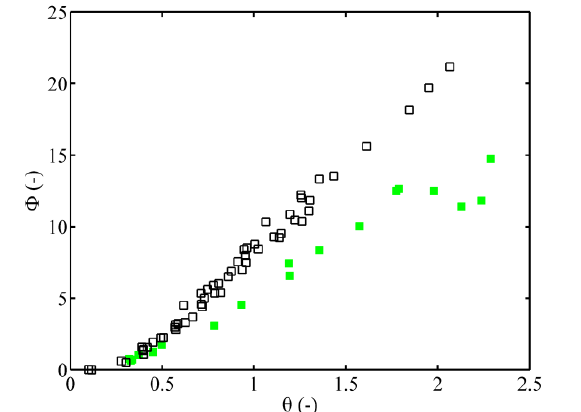
Fig. 7. Dimensionless sediment flow rate (Einstein parameter) versus dimensionless bed shear stress (bed Shields parameter). Legend: empty square – TLT50, full square –